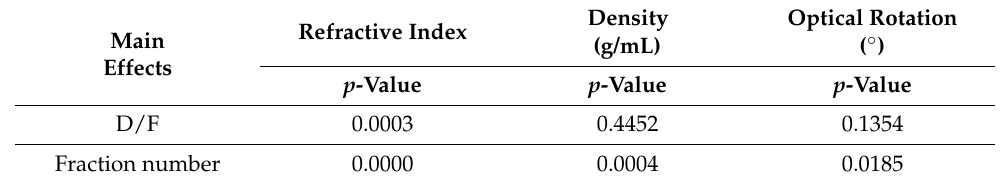
Table 1. Effect of the D/F and the fraction number in the refractive index, density, and optical rotation.